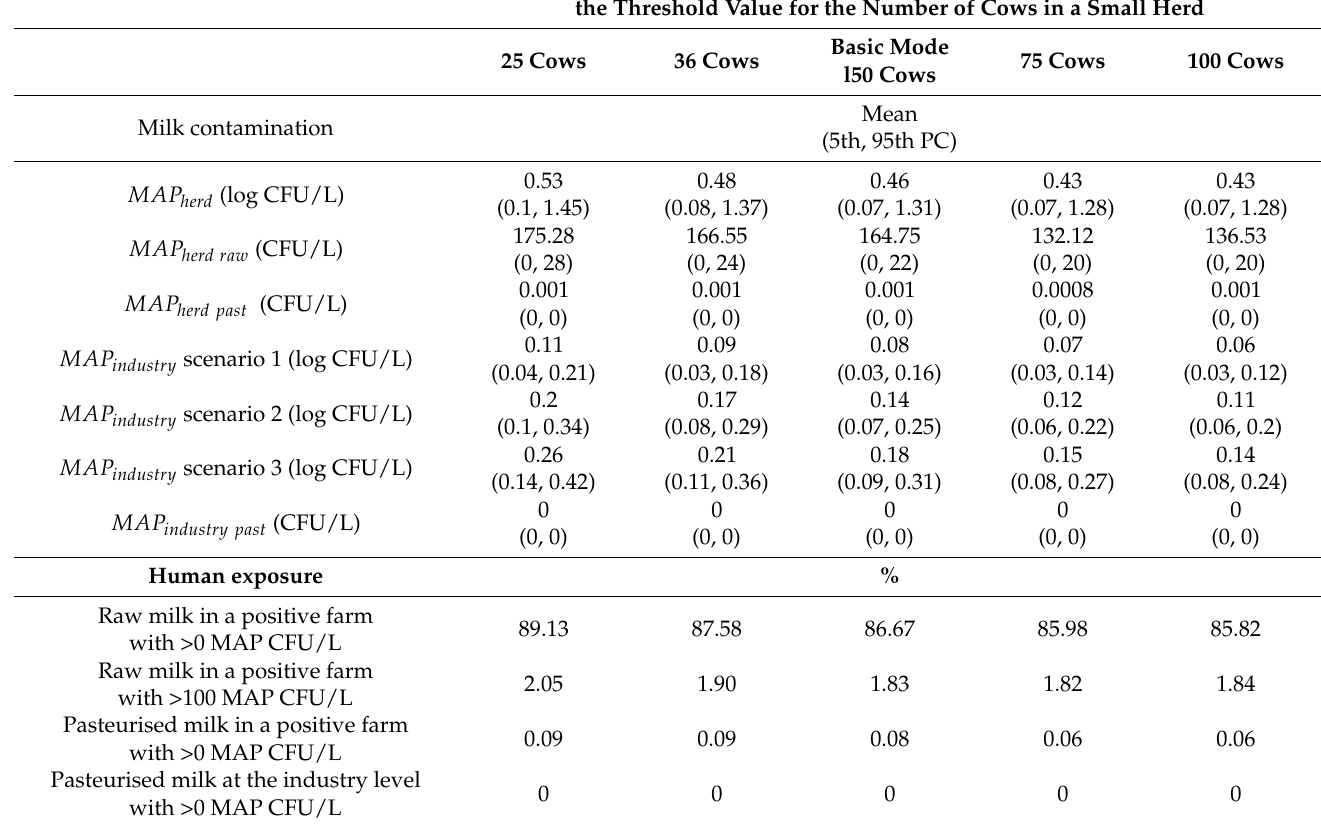
Table 3. Results of sensitivity analysis of small herd size thresholds in the risk assessment model of human exposure to Mycobacterium avium subsp. paratuberculosis (MAP) via different types of milk. the Threshold Value for the Number of Cows in a Small Herd 25